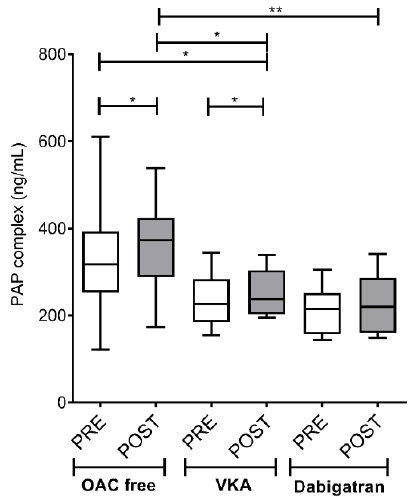
Figure 3. Left atrium plasmin-antiplasmin (PAP)-complex levels before and after cryoballoon ablation procedure in AF patients on various pre-procedural anticoagulation strategies. Box and whisker plots indicate median, interquartile range, and total range. PRE (empty bars): pre-ablation, POST (solid bars): post-ablation, OAC: oral anticoagulant, VKA: vitamin K antagonist. * p < 0.05, ** p < 0.01. Statistical significance remained essentially the same when assessed after controlling for the e ff ect of covariates associated with selection (age, sex) between treatment